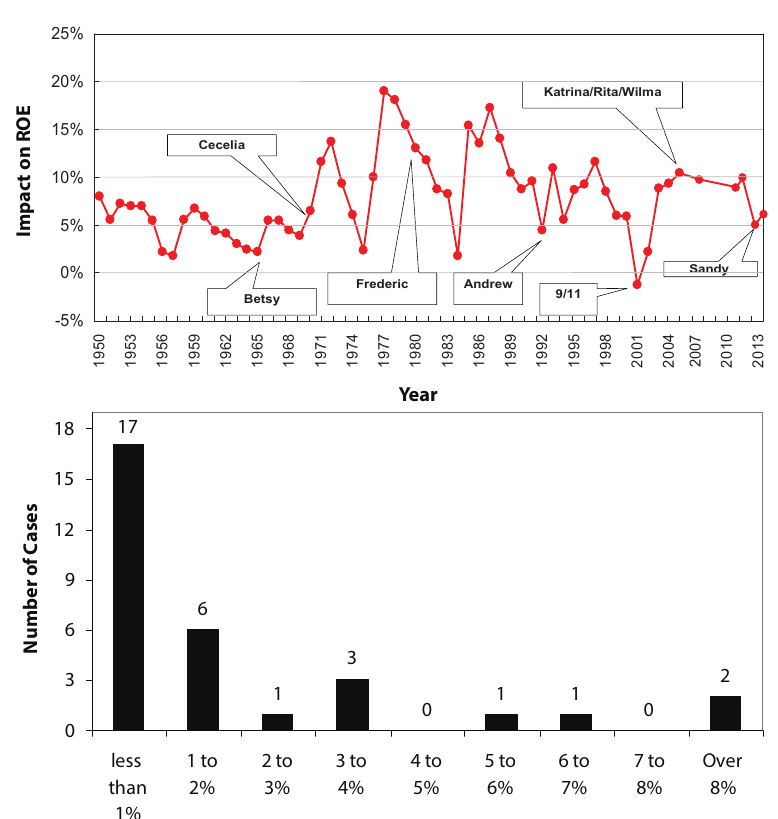
Figure 3. Top : Impact of selected large-loss hurricanes on return on equity for the insurance industry: 1950–2013. Bottom : The distribution of the ratio of hurricane losses to policyholder surplus (here noted as “Number of Cases”): 1950–2013 (source: Insurance Information